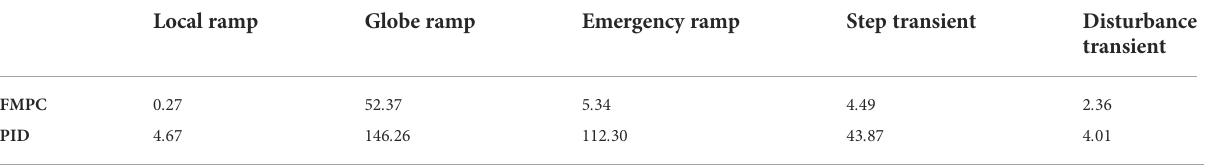
TABLE 2 ITSE values of the FMPC controller and PID controller for the fi ve simulated transient operation conditions. Local ramp